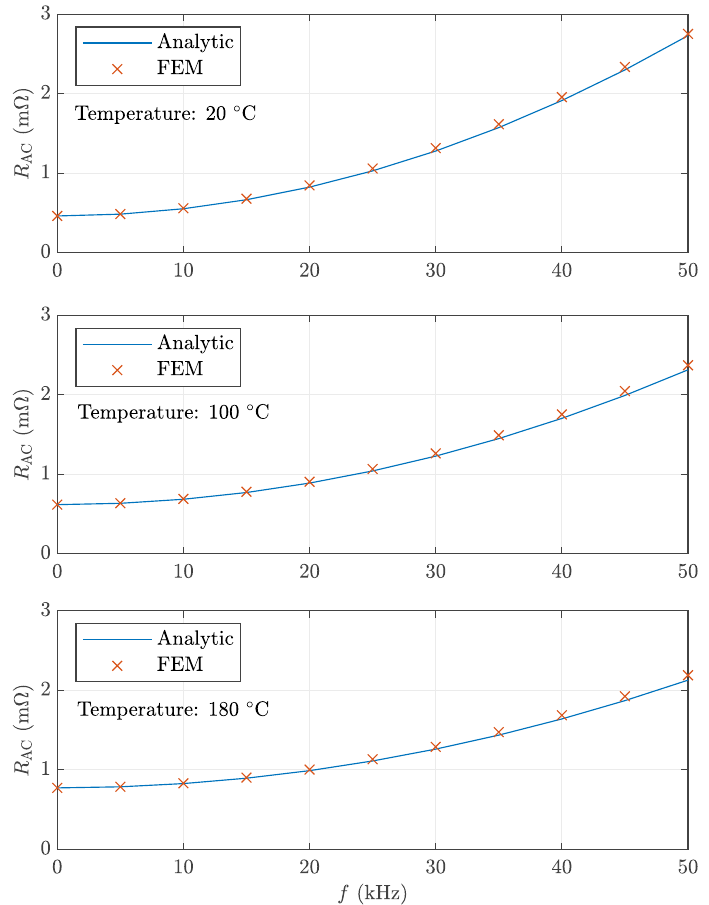
Figure 4. Comparison between analytic and FEM-calculated AC resistances at different frequencies and